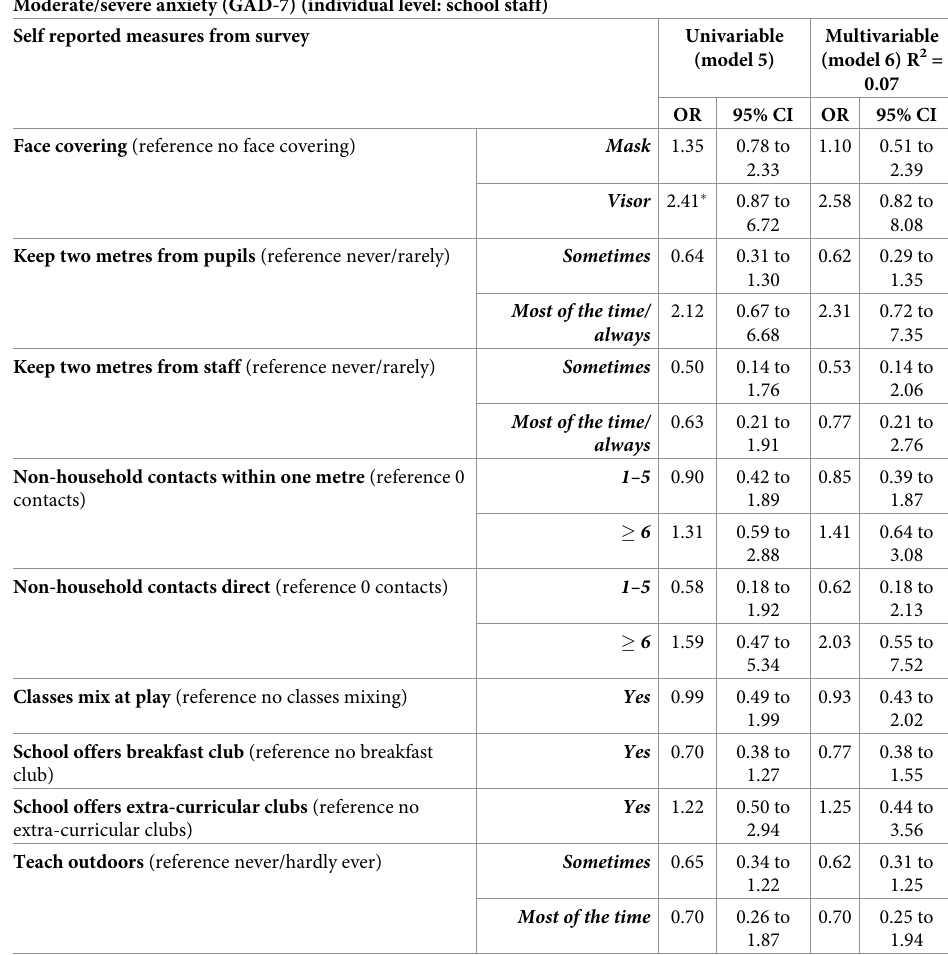
Table 5. Univariable (model 5) and multivariable (model 6) logistic regression models of self-reported school- based mitigation measures (survey) and individual level (school staff) moderate/severe anxiety symptoms (survey). Moderate/severe anxiety (GAD-7) (individual level: school staff) Self reported measures from survey